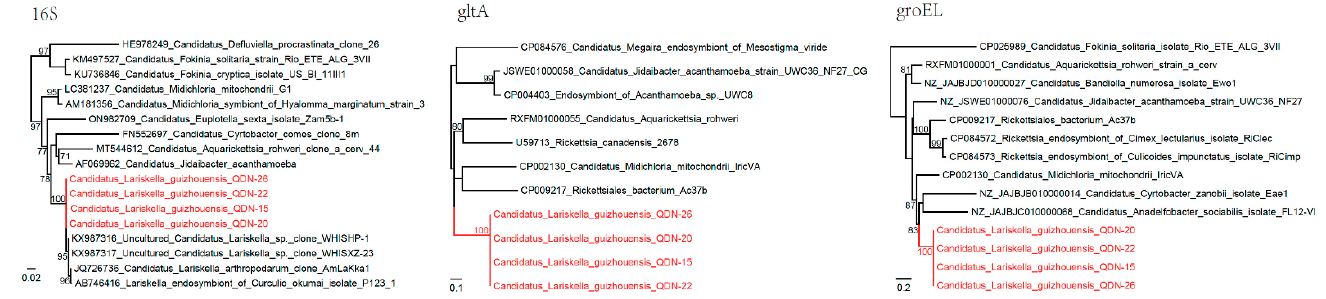
Figure 3. Phylogenetic trees based on the nucleotide sequences of 16S rRNA ( rrs ), gltA , and groEL genes of the Candidatus Lariskella isolates. Red: Sequences obtained in this study.